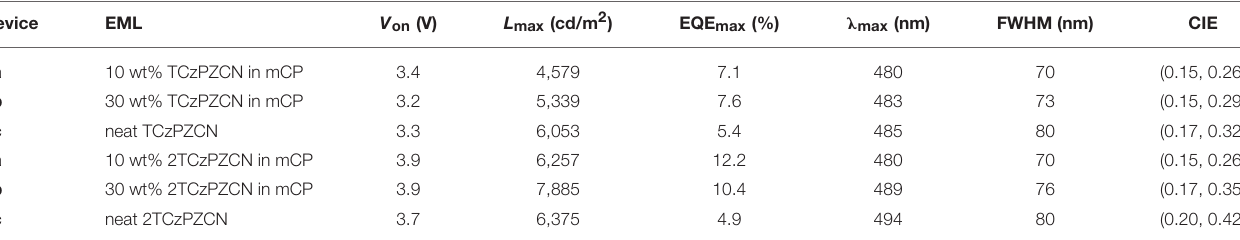
TABLE 3 | Emissive layer (EML) component, turn-on voltage ( V on ), maximum luminance ( L max ), external quantum efficiency maximum (EQE max ), emission maximum ( λ max ), full width at half maxima (FWHM), and CIE coordinates of the TADF